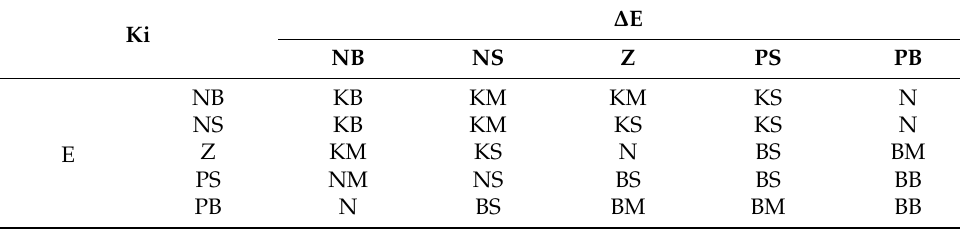
Table A2. Fuzzy-PID Tuning Rules for Constant Ki.